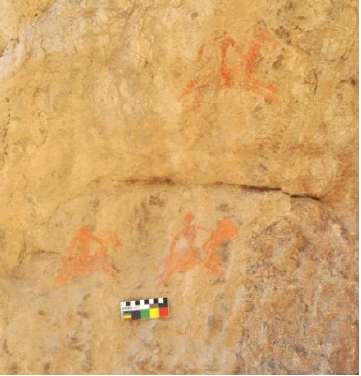
Figure 18. Site V. Painting of horse riders on the northern side of the